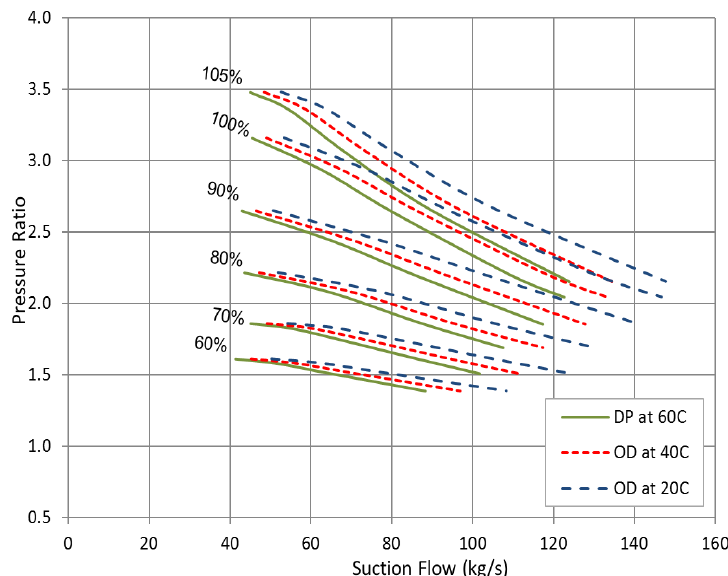
Figure 16. Effect of suction pressure and temperature on compressor pressure ratio at constant discharge pressure.